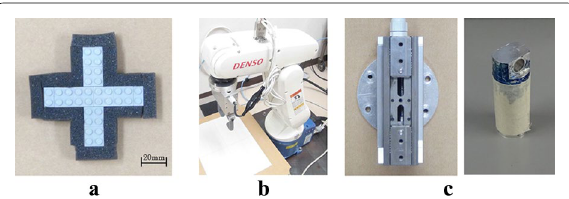
Fig. 9 Experimental equipment. a Manipulator, b two-fingered hand, and c